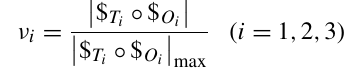
mission index of the limb is constant and its value is always equal to 1. It means that this manipulator has high quality of input